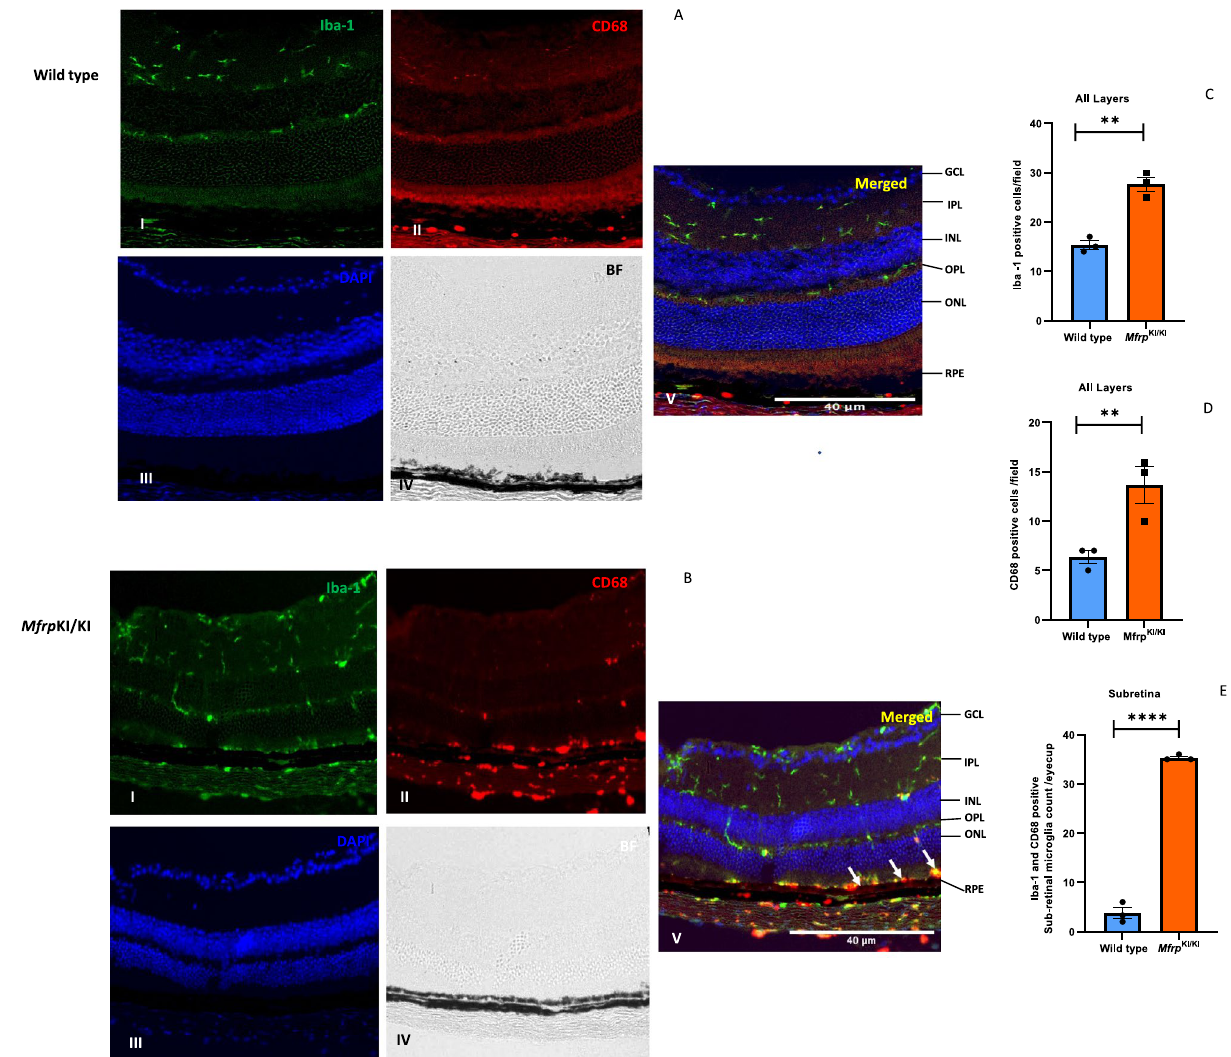
Figure 3. Immunohistochemistry studies for CD68 and Iba-1 positive cells in retinal cryosections ( A,B ) Iba- 1(green) and CD68 (red) positive cells were prominent and strongly positive subretinal region (white arrows) and with occasional cells with co-localized immunostaining in the OPL and IPL in Mfrp KI /KI retina, whereas in WT mice, microglia with Iba-1 cells were confined to the OPL and IPL and completely absent from the subretinal region (I-Iba-1, II-CD68, III-DAPI, IV-Brightfield (BF), V-Merged) and had few cells with CD68 immunostaining. ( C,D ) Iba-1 and CD68 count in both groups (** p < 0.01 and ** p < 0.01) (n = 3). ( E ) The number of subretinal microglia were significantly higher in Mfrp KI /KI retina compared to WT retina (**** p < 0.0001) (n = 3) ( GCL ganglion cell layer, IPL inner plexiform layer, INL inner nuclear layer, OPL outer plexiform layer, ONL outer plexiform layer, RPE retinal pigment epithelial cell